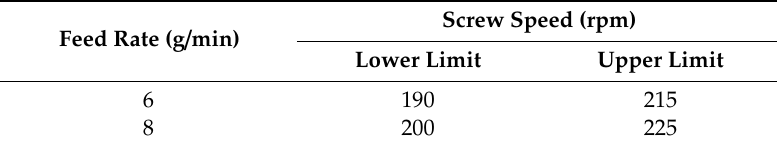
Table 7. Method operable design region for feed rate and screw speed.